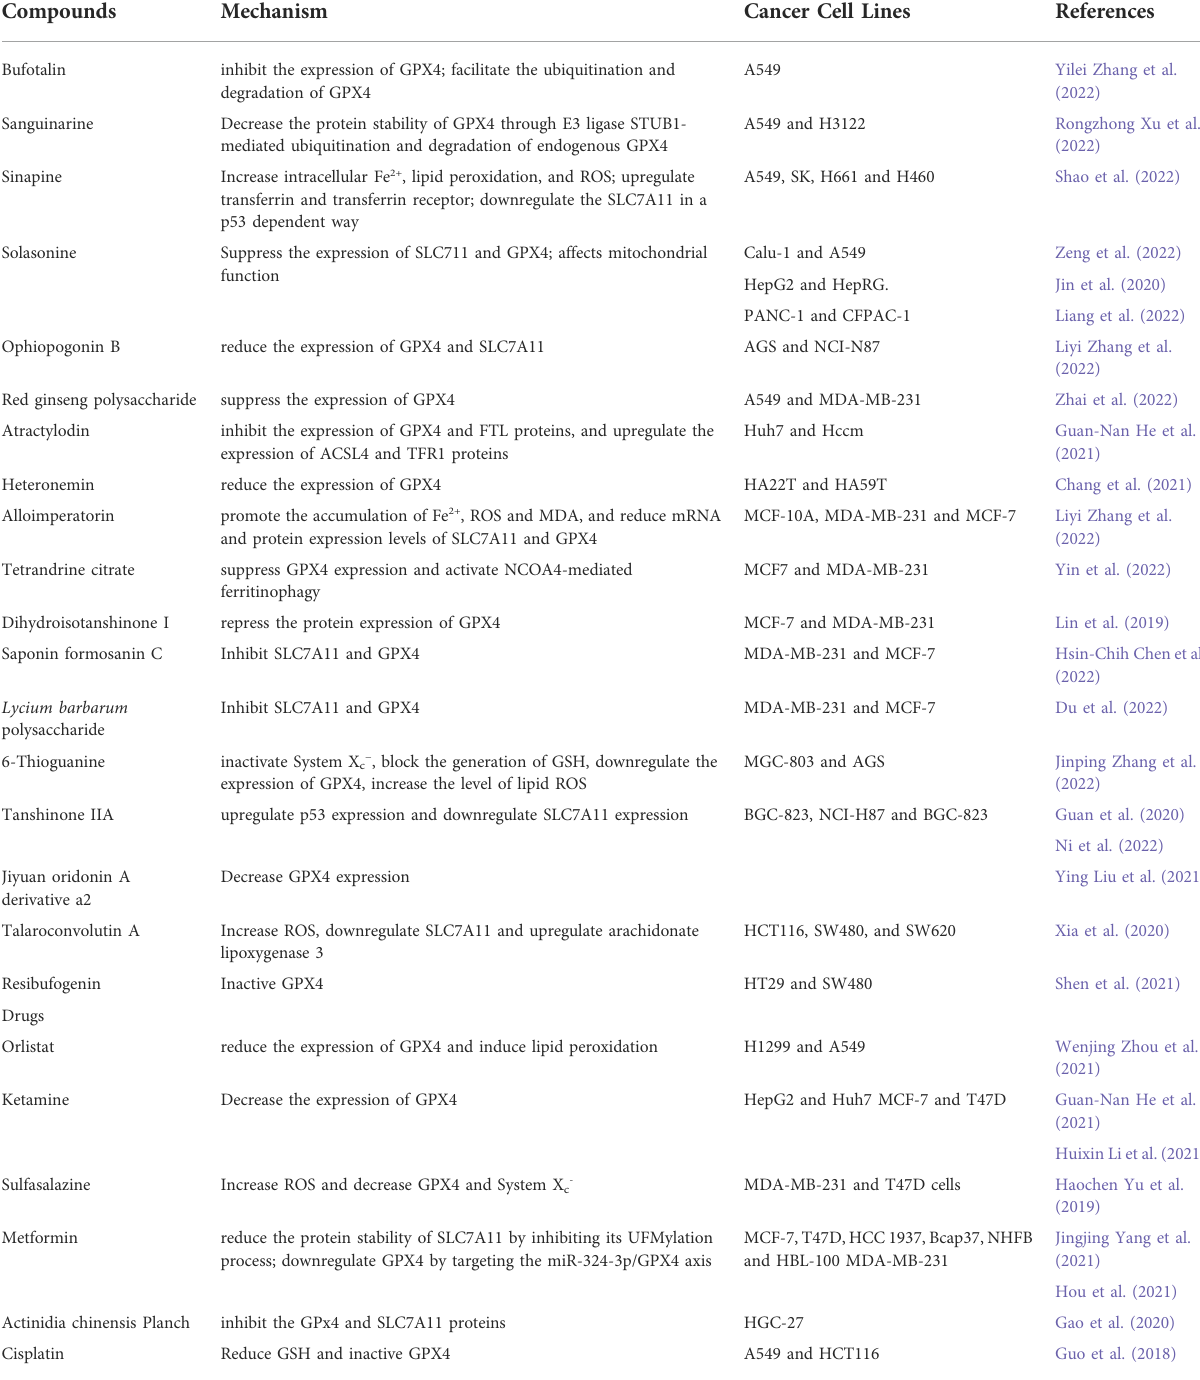
TABLE 2 Drugs and compounds based on System X c − /GSH/GPX4 for treatment of drug-resistant solid tumors.